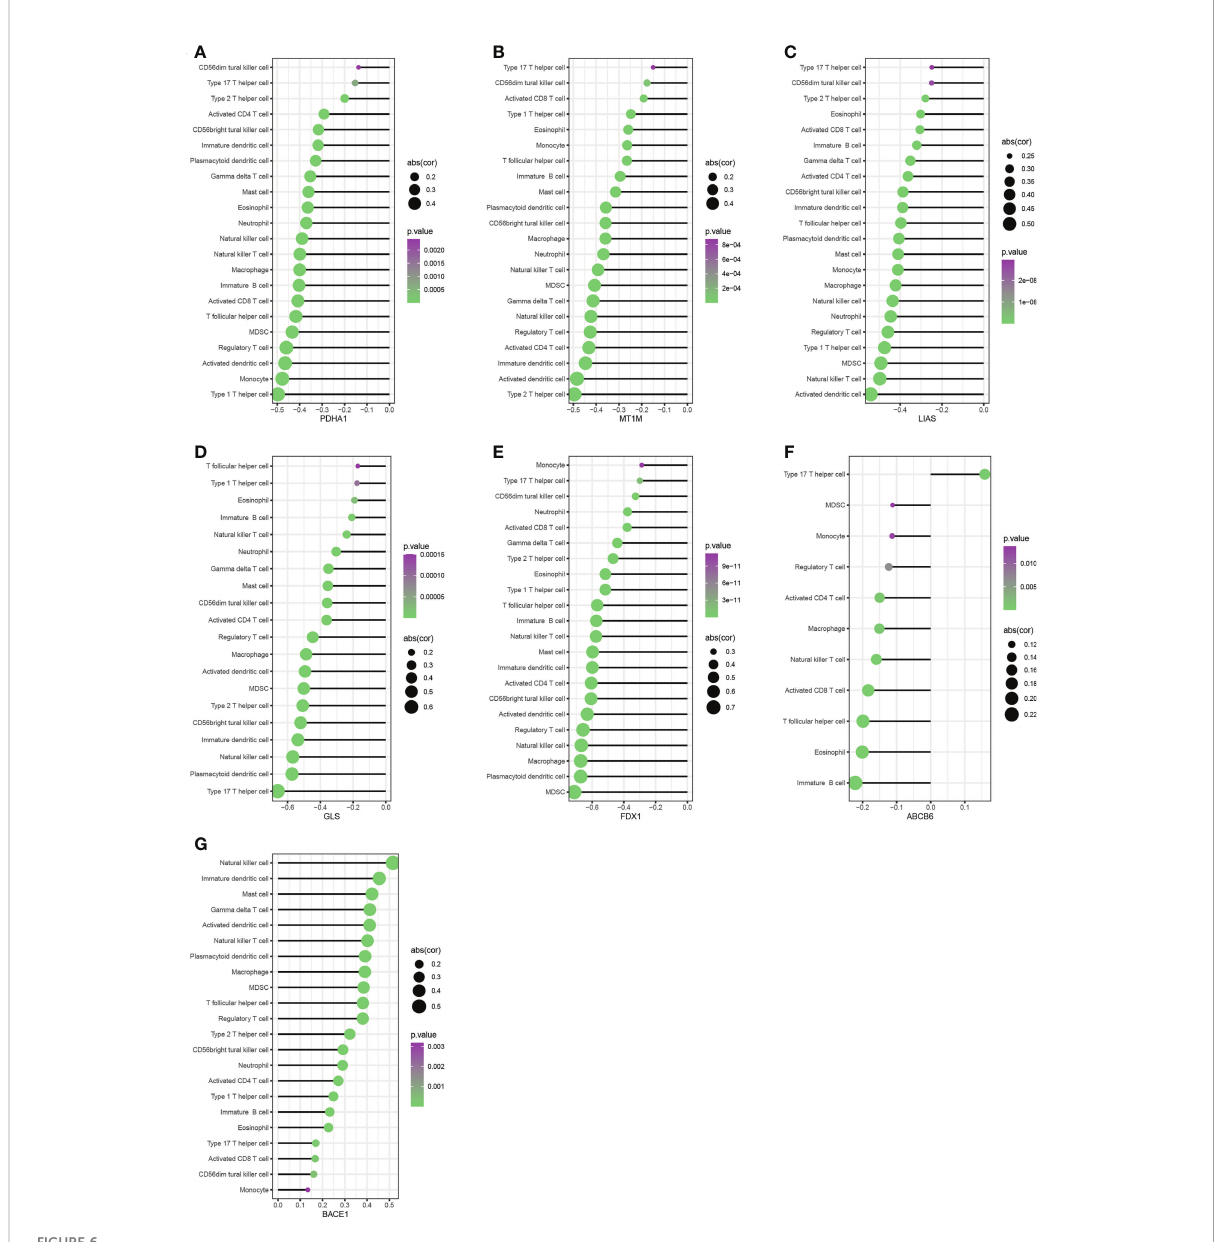
FIGURE 6 Correlation between immune in fi ltrating cells with PDH1, MT1M, LIAS, GLS, FDX1,ABCB6 and BACE1 (A – G)